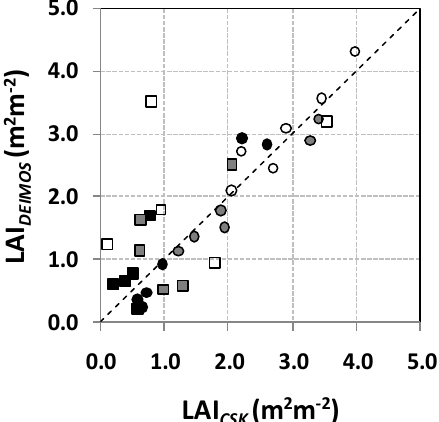
Figure 9. LAI vs. LAI: minima (in black), averages (in gray) and maxima (in white) CSK calculated over corn ( ui09 , ui11 , ui12 , ui17 , ui18 , ui20 , circles) and alfalfa ( ui04 , ui05 , ui15 , squares) plots from 3 August to 5 September.